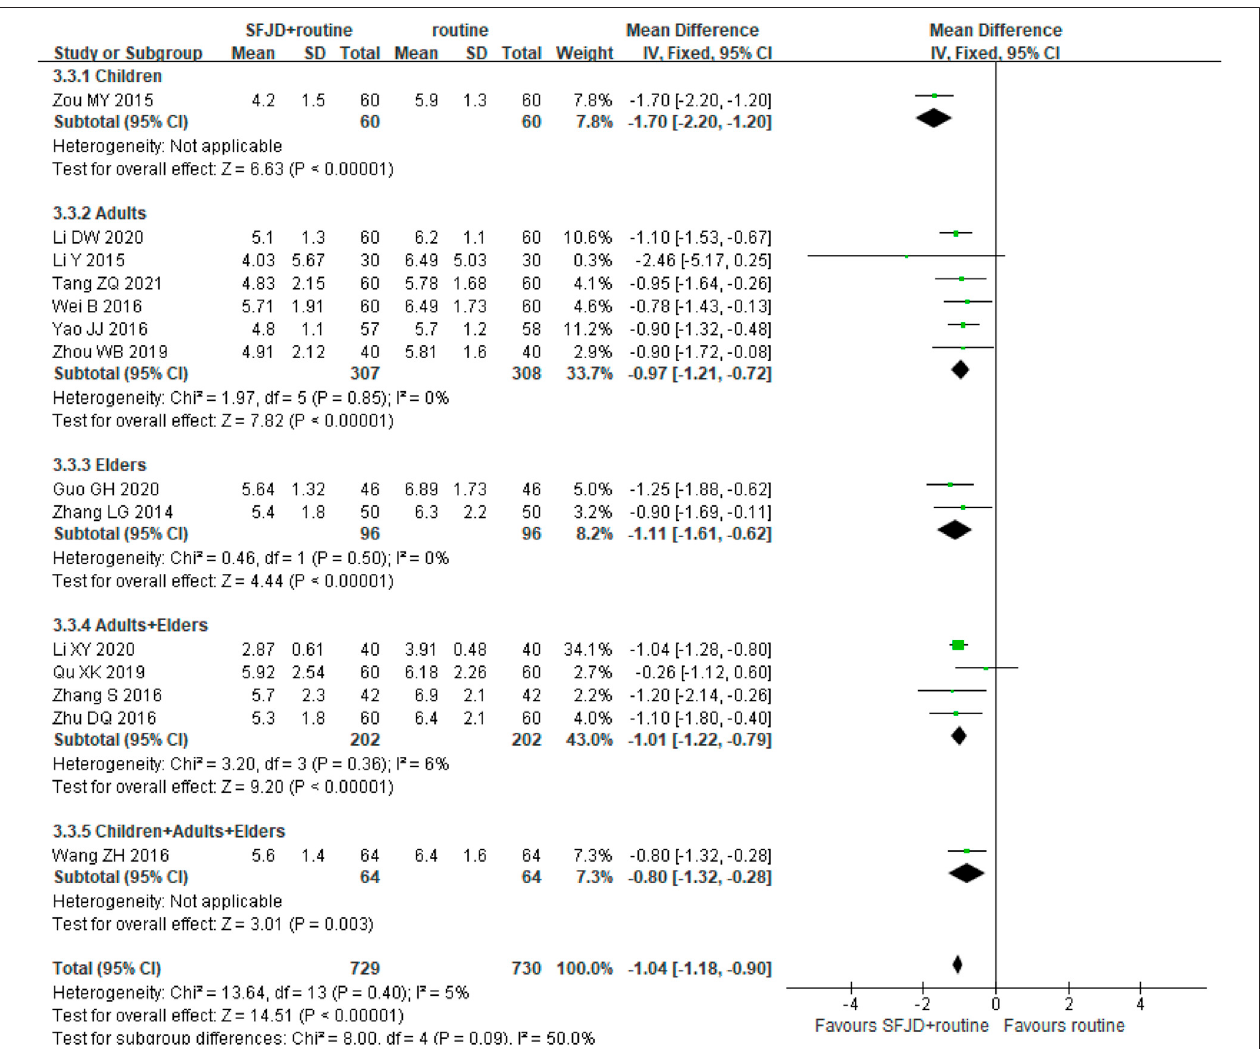
FIGURE 4 | Forest plot of duration of cough (days) strati fi ed by age. Comparison: SFJD plus routine treatment vs. routine treatment. SFJD: Shufeng Jiedu.